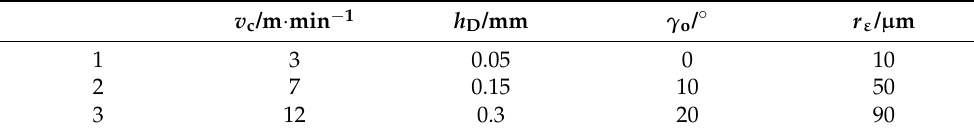
Table 2. Factors and levels of orthogonal test.